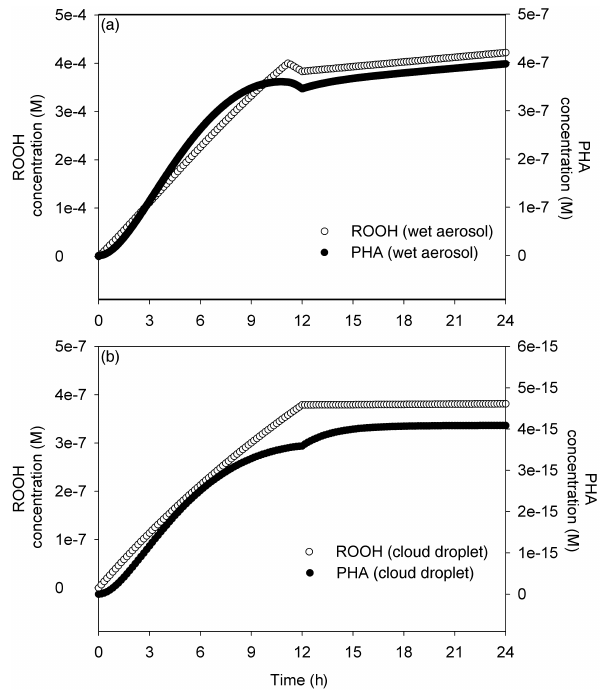
Figure 10. The simulated atmospheric concentrations of ROOH (or- ganic peroxides) and PHA (peroxyhemiacetals) in wet aerosols (a) and cloud droplets (b) during 24h. The first 12h are